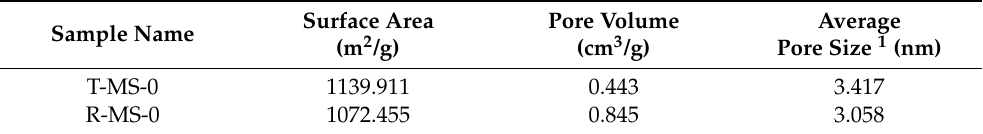
Figure 5. Specific pore size distributions for T-MS-0 and R-MS-0. Table 1. The textural properties of T-MS and R-MS.